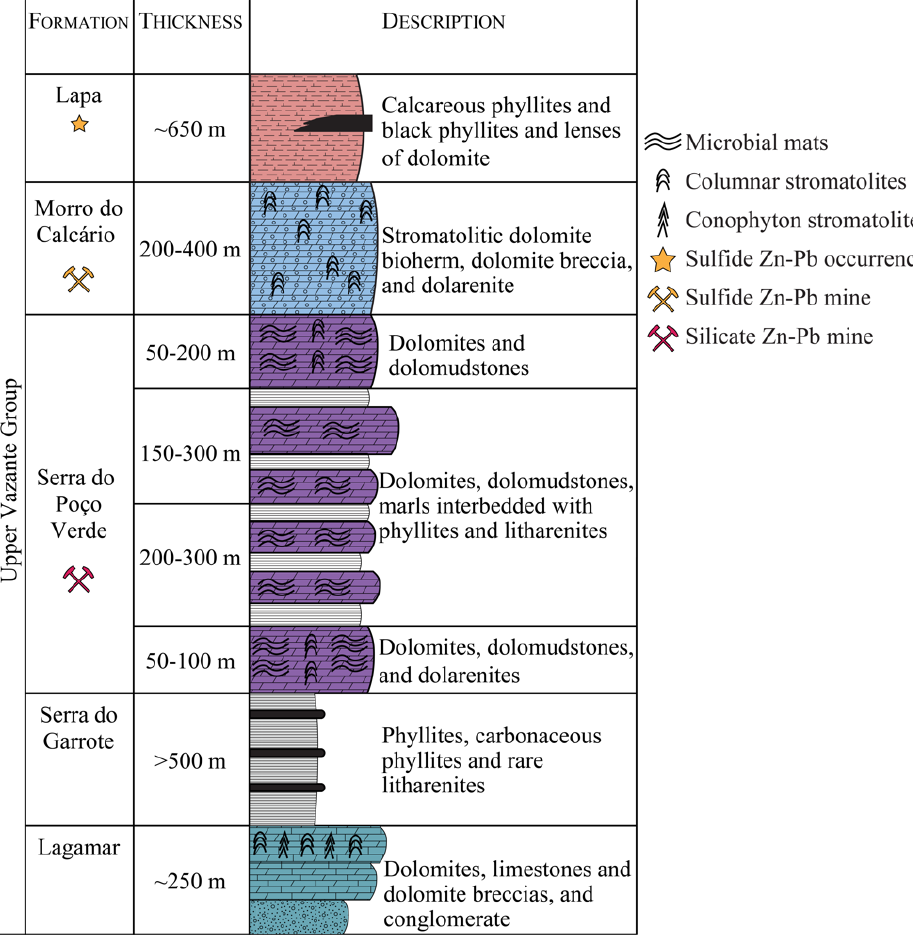
Figure 2. Upper Vazante Group stratigraphy showing the lithological controls on the various base metal deposits and occurrences (modified from [1,3,11,12,15]).